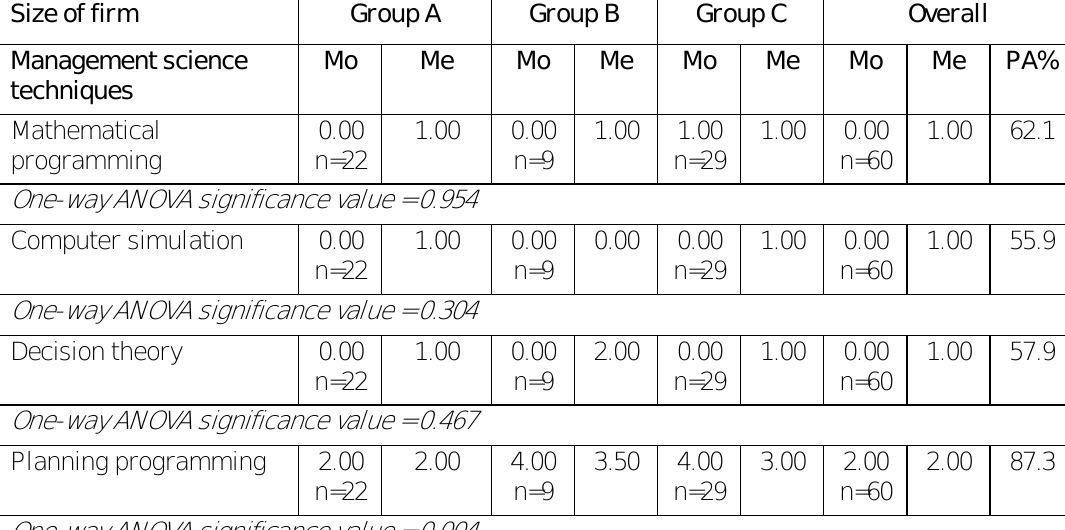
Table 4: Comparisons of the usage of management science techniques Size of